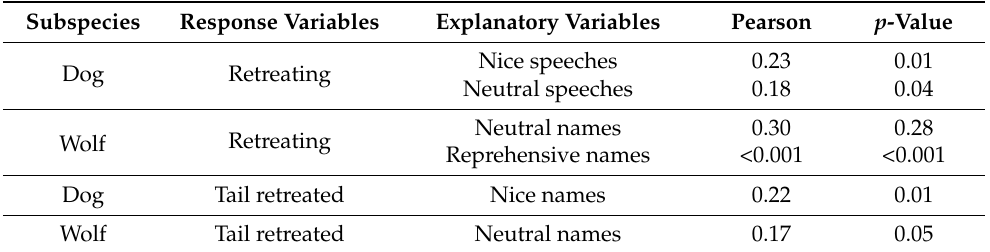
Table 7. Pearson correlations run for dogs ( Canis familiaris ) and wolves ( Canis lupus ), considering the effects of the variables nice speeches, nice names, neutral speeches, neutral names, and reprehensive names on the response variables retreating and tail retreated.